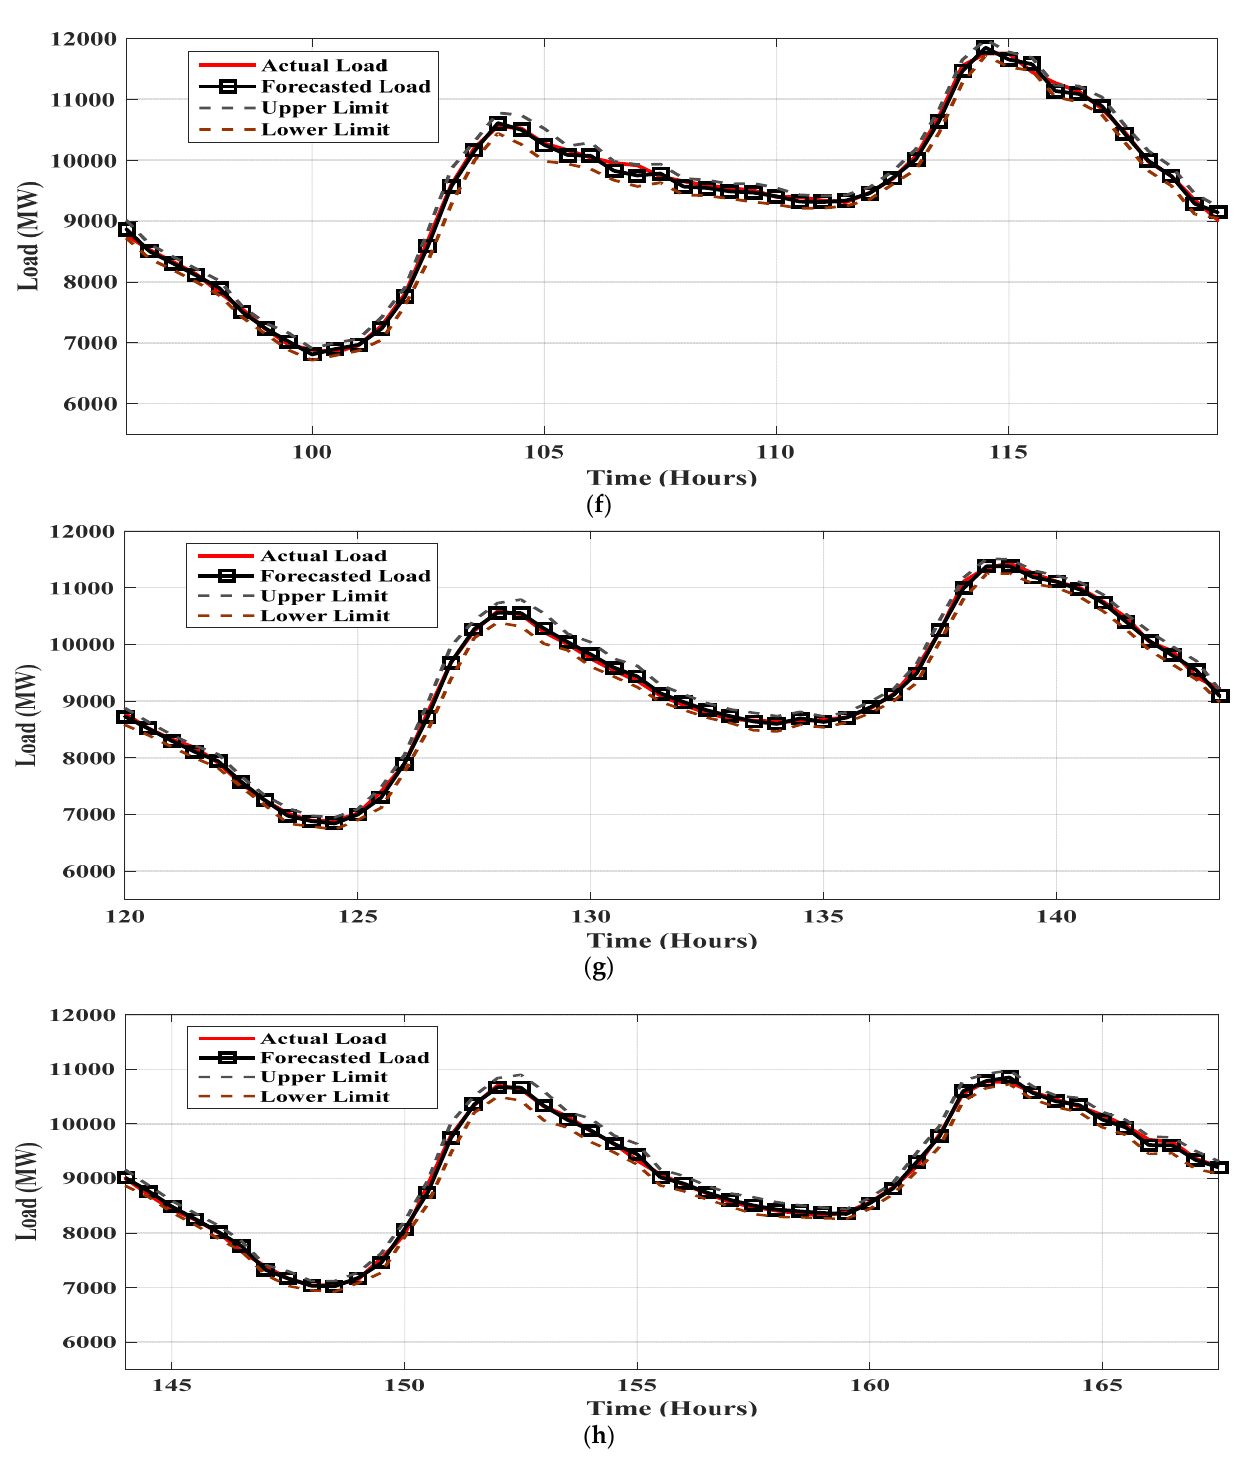
Figure 4. Forecasting in winter 1–7 August 2015 with M5P +FS, ( a ) entire week, ( b – h ) daily forecast.